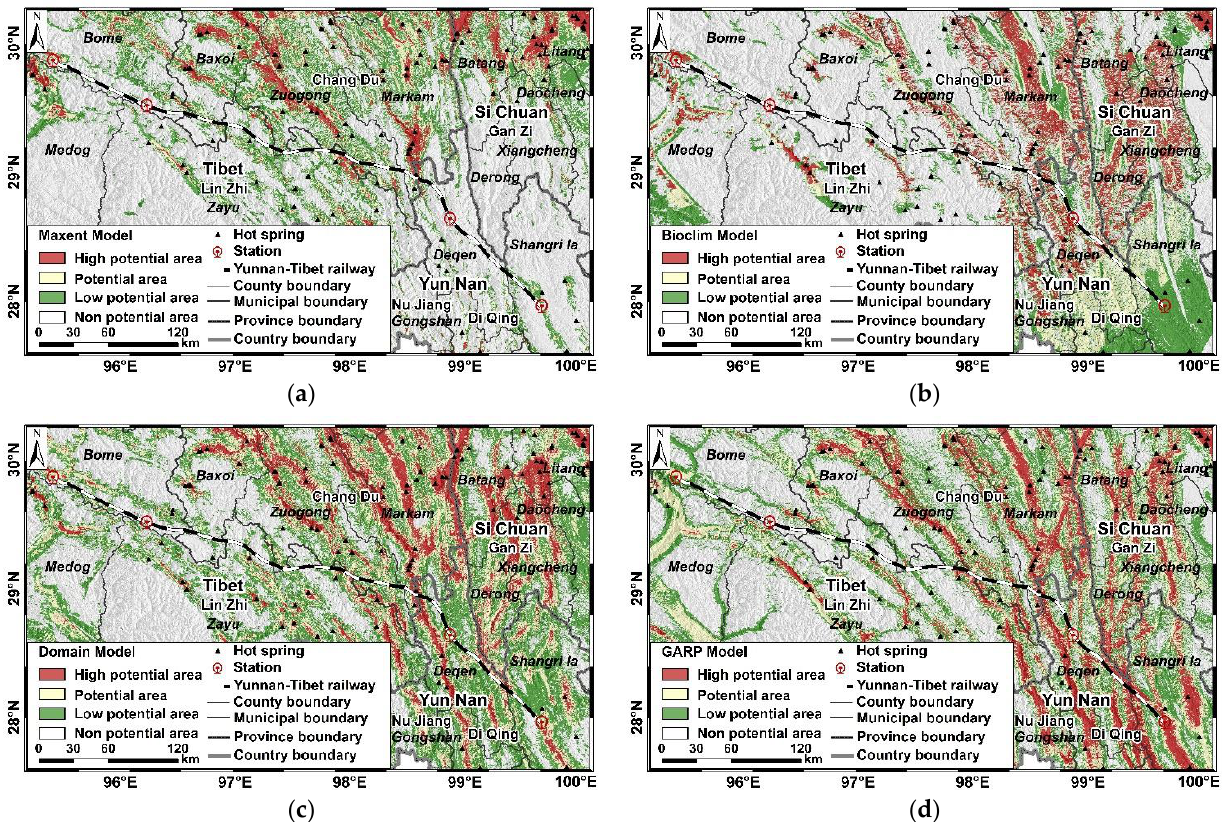
Figure 5. Predicted classification maps: ( a ) MaxEnt model, ( b ) Bioclim model, ( c ) Domain model, ( d ) GARP model.